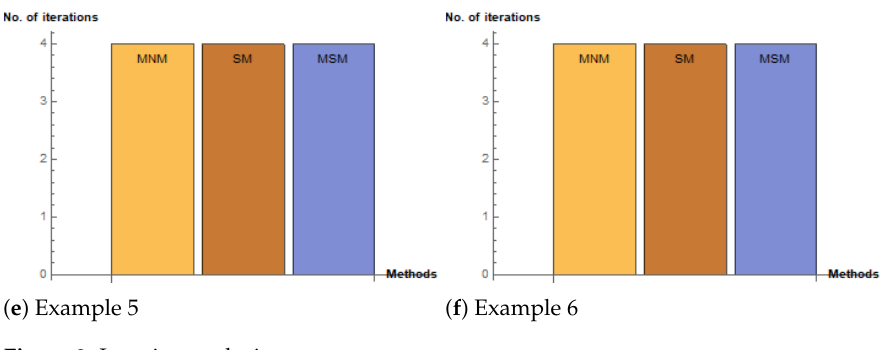
Figure 2. Iteration analysis.